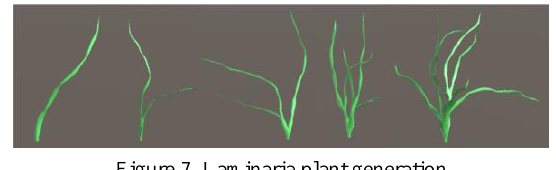
Figure 7. Laminaria plant